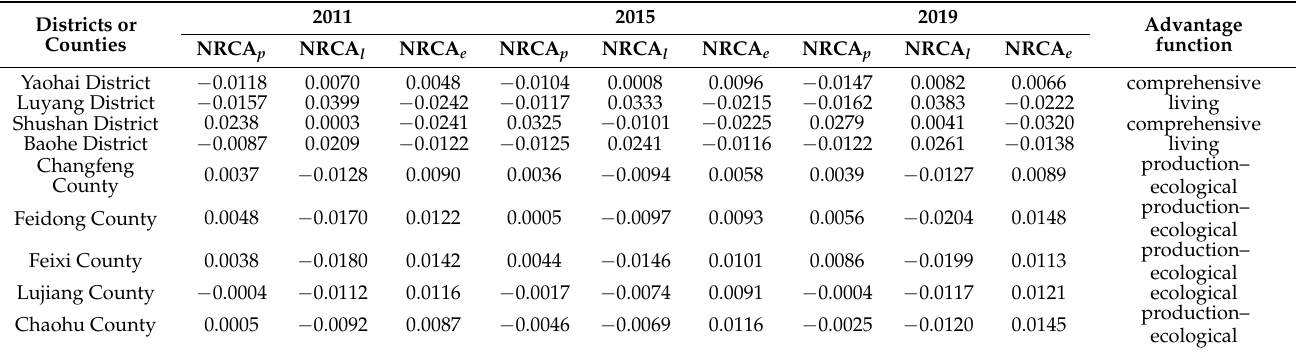
Table 5. Discrimination of PLE functional advantages in all districts and